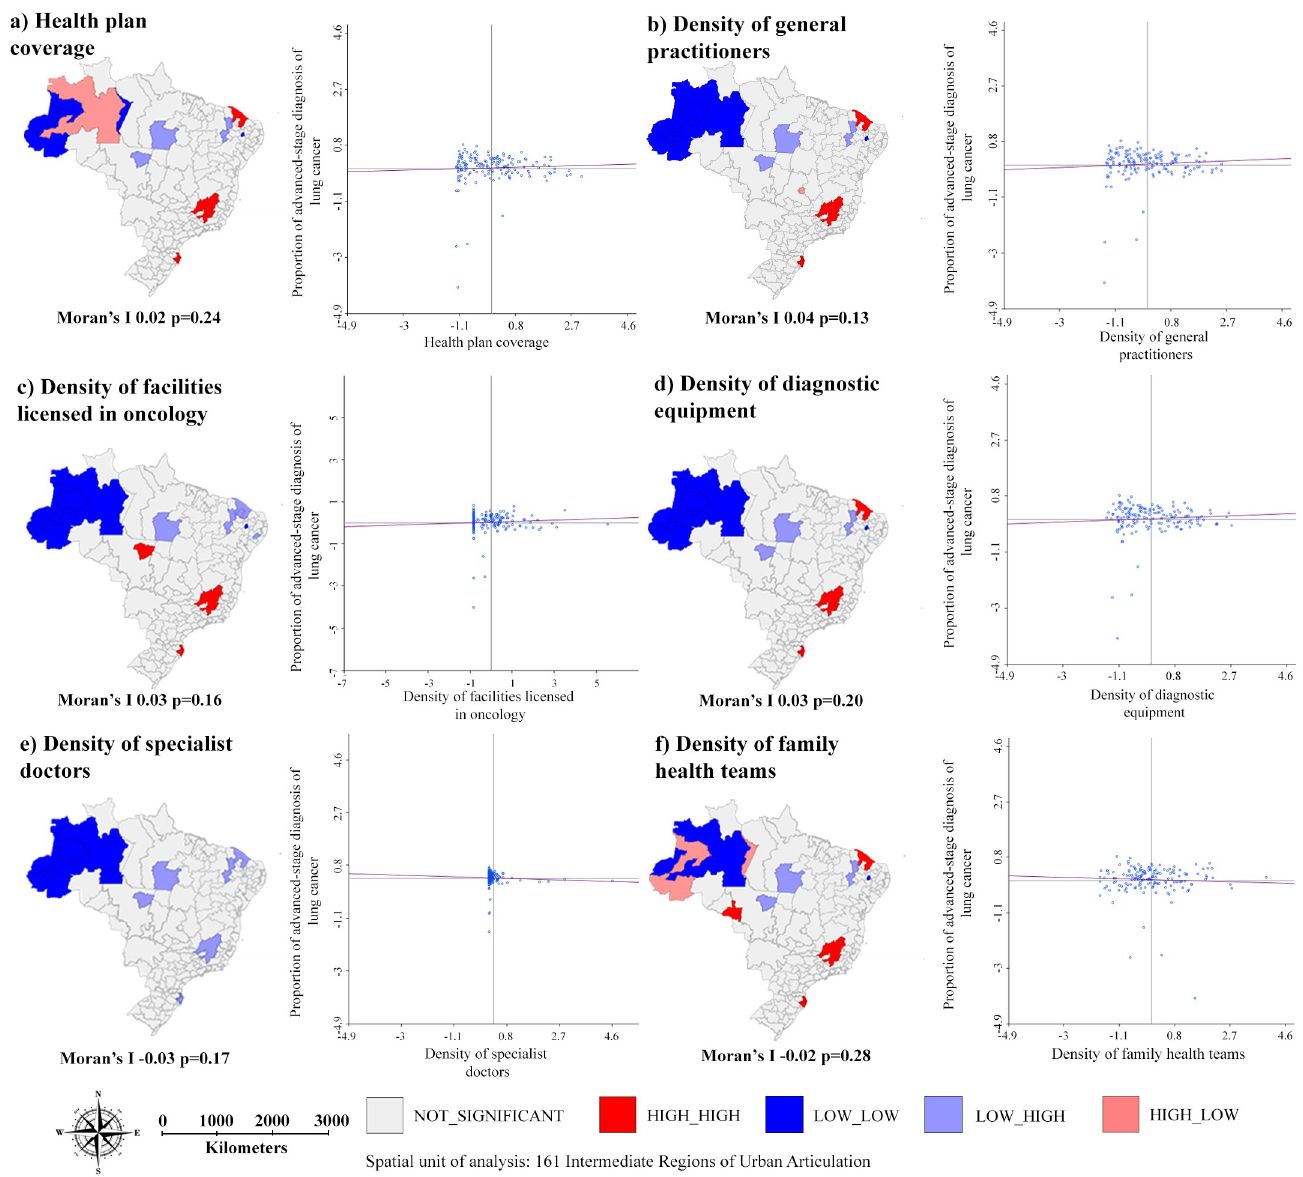
Fig 4. Spatial association between proportion of advanced-stage diagnosis of lung cancer, for both sexes, and healthcare services supply indicators per IRUA, Brazil, 2011–2015.